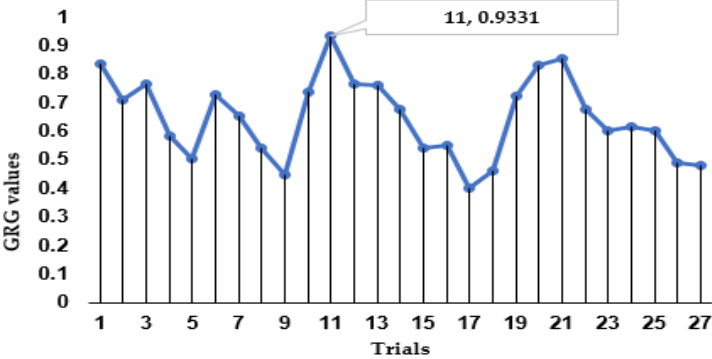
Figure 17. Graph showing the peak ranking of the trials of the GRG.